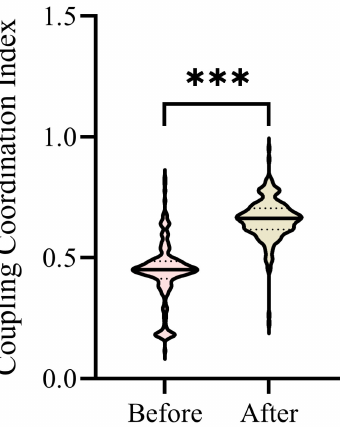
Figure 5. Coupling coordination degree of livelihood capital before and after implementation. (***: p <